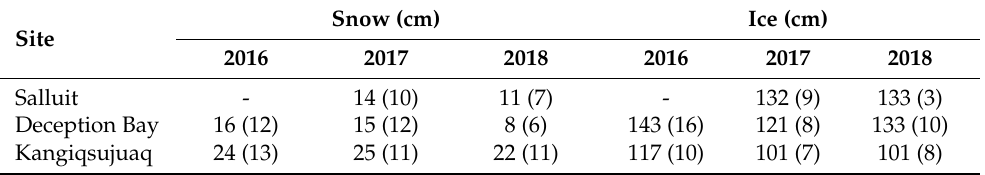
Table 3. Mean April–May snow depth and ice thickness with standard deviations in parentheses. Snow Site